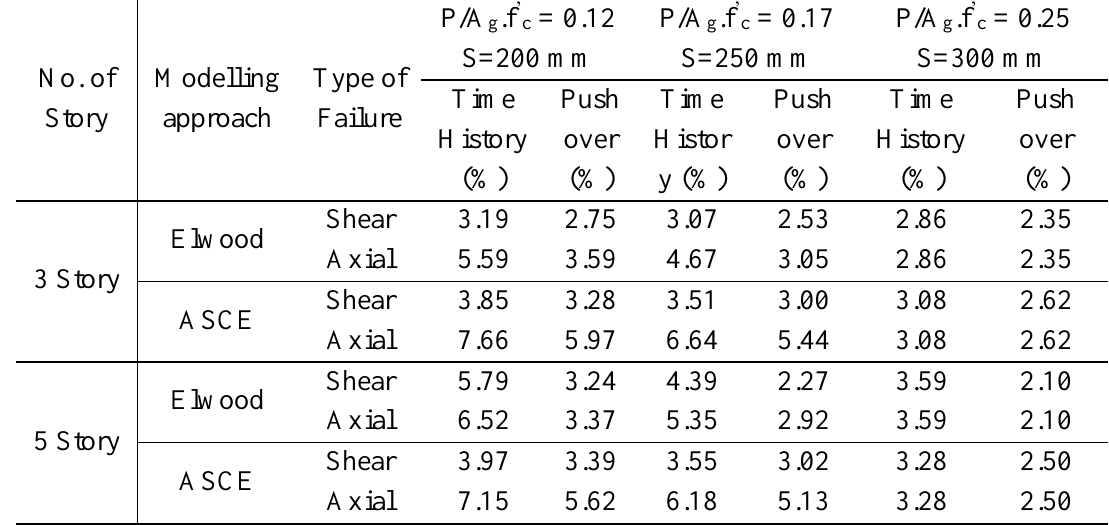
The mean of maximum inter-story drift ratio at first shear and axial failure derived from